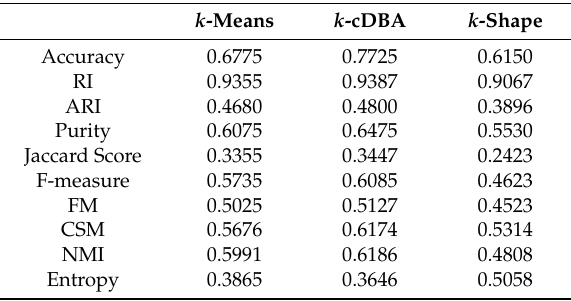
Table 4. The evaluation result of k -means, k -cDBA and k -shape, illustrated by 10 external indexes.